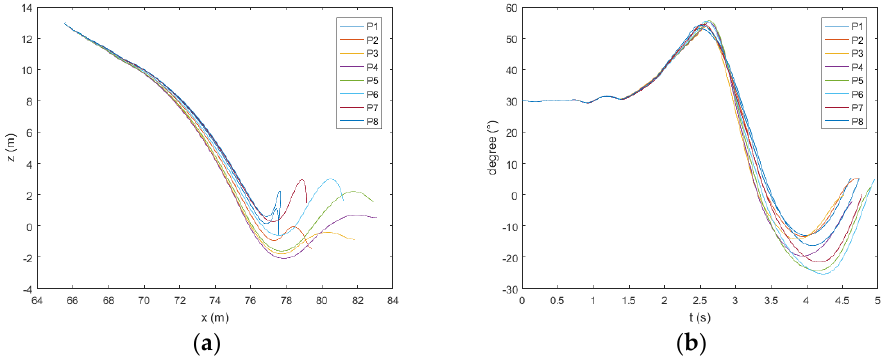
Figure 21. Trajectory ( a ) and pitch ( b ) of the lifeboat freefall when the wave height is 3 m.